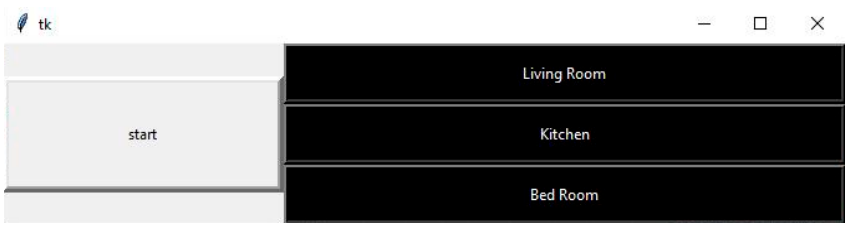
Figure 3. User interface for selecting the desired destination.